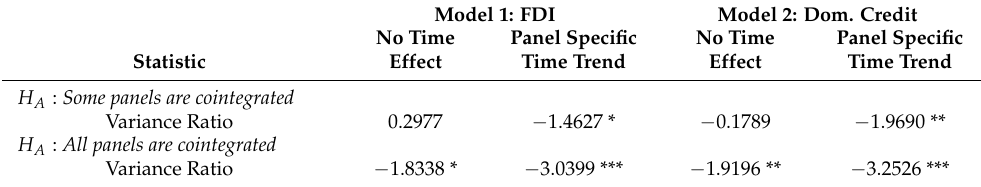
Table 4. Results of the Westerlund panel cointegration